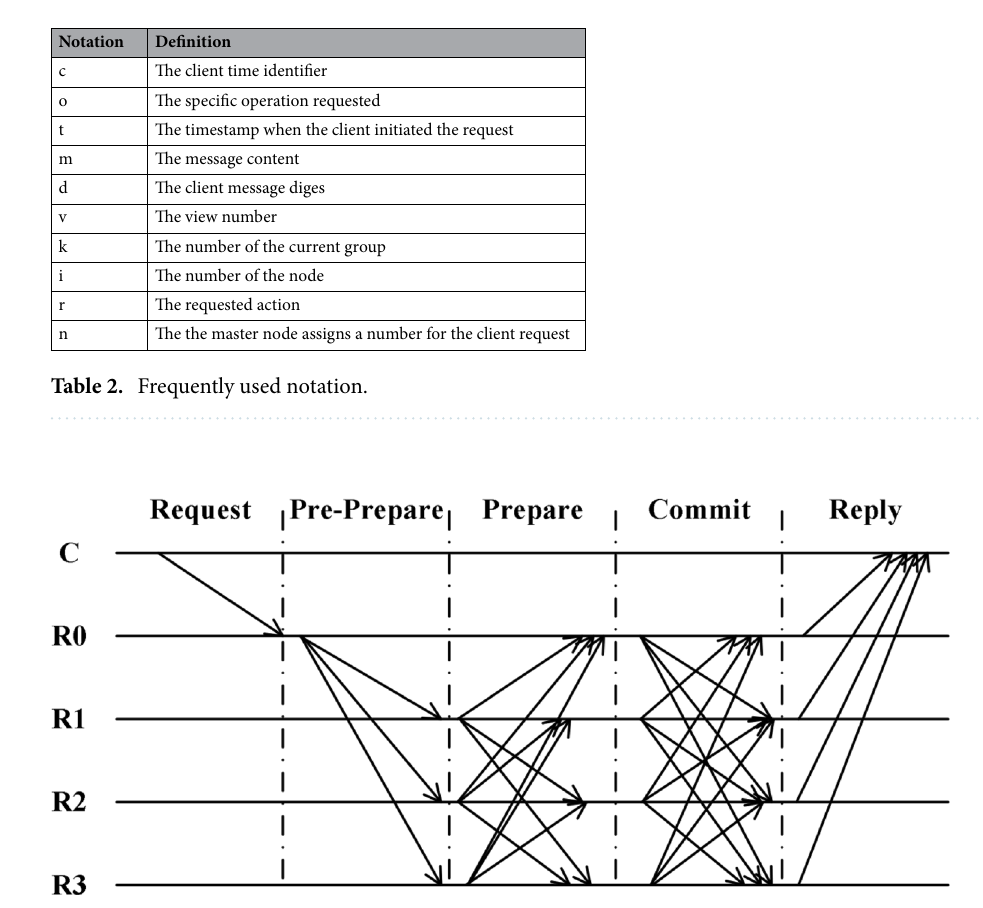
Figure 1. PBFT algorithm flow